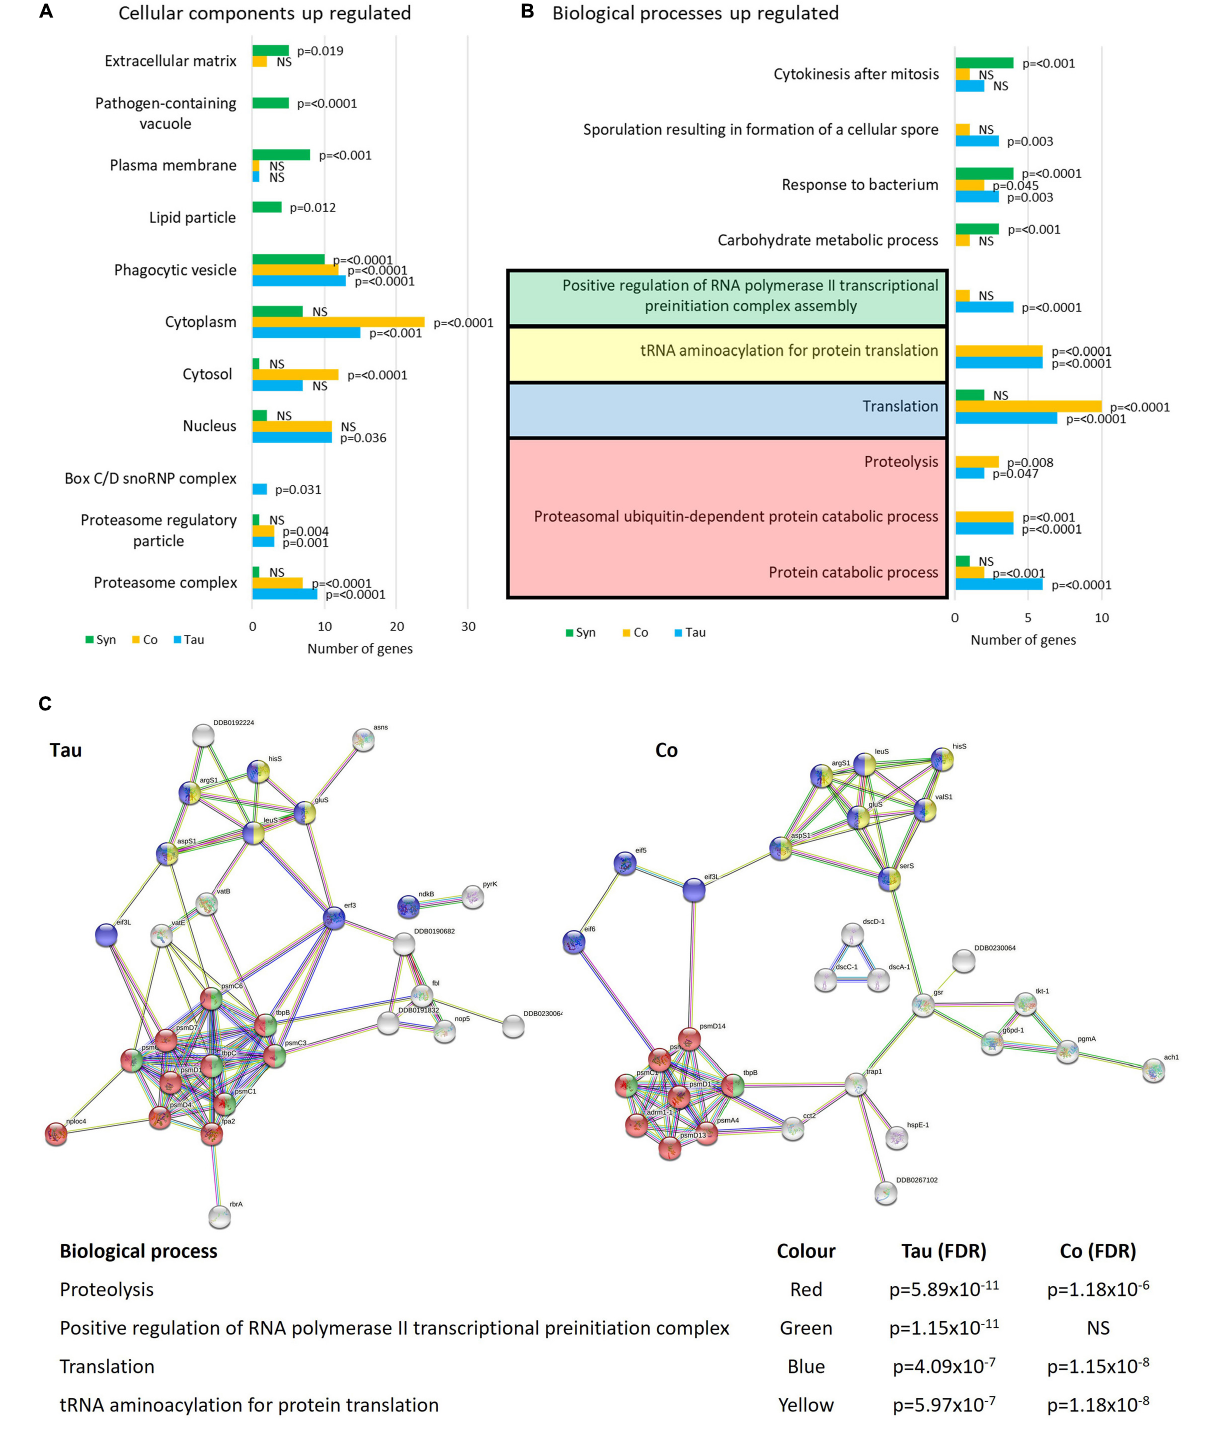
FIGURE 9 | Cellular components and biological processes up-regulated in strains expressing tau and/or α -synuclein. Funrich enrichment analysis of cellular components (A) and biological processes (B) indicate that tau affects the proteasome and proteolytic processes as well as translation. The expression of α -synuclein resulted in different biological processes and therefore different cellular components being affected. The cotransformants displayed patterns of up-regulated expression similar to those in strains expressing tau alone. The reported p -values are based on hypergeometric tests (A) and corrected using the Bonferroni method